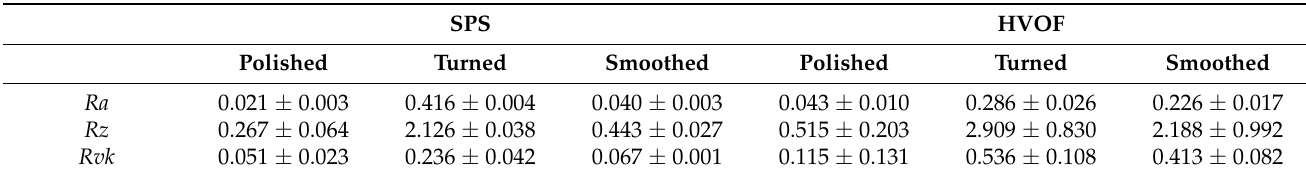
Table 4. Mean values for the arithmetic mean surface roughness ( Ra ), the surface roughness depth ( Rz ), and the reduced valley depth ( Rvk ) of the specimens finished surfaces (in µm), errors represent standard deviation.